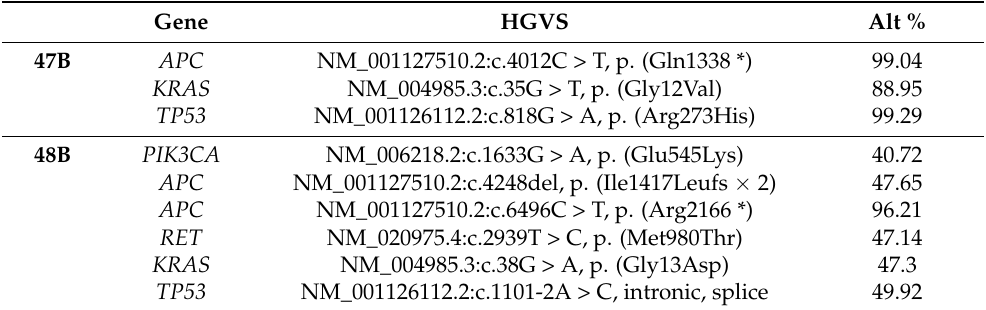
Table 2. Molecular characteristics of tumor samples 47B and 48B excised from tumor-bearing mice. * is specific character of labeling of HGVS; * = translation termination